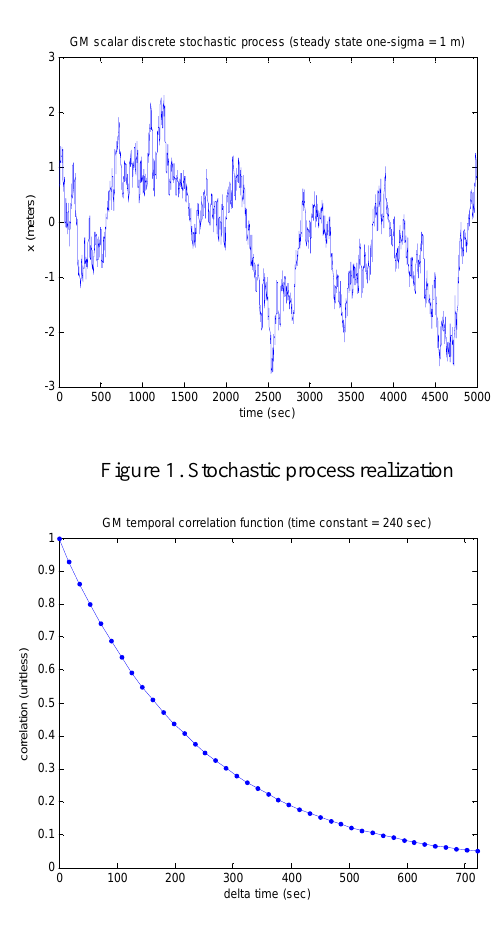
Figure 2. Stochastic process temporal correlation